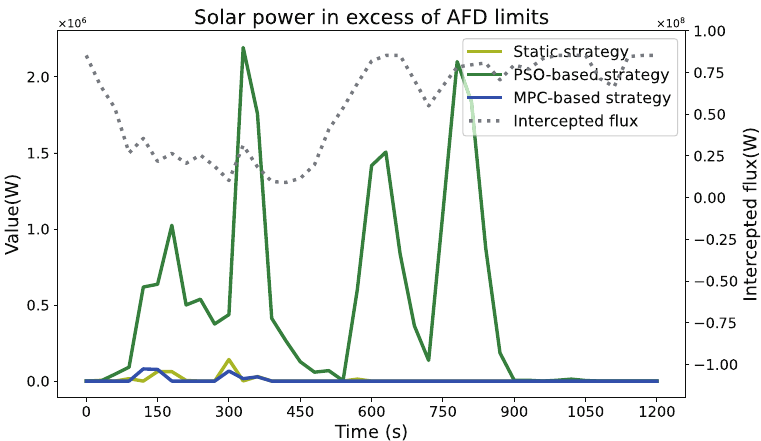
Figure 10. The solar flux distribution uniformity of the three aiming